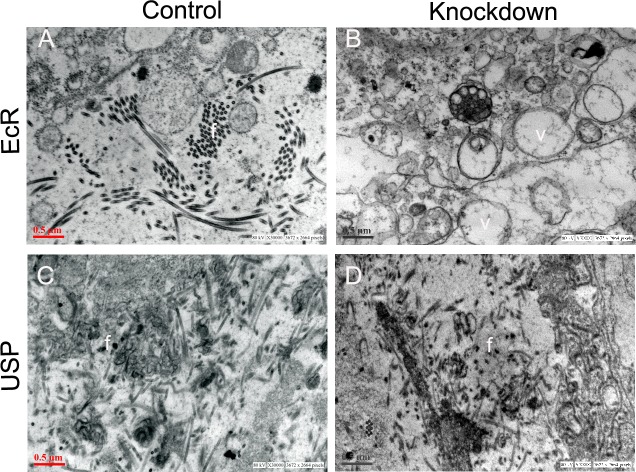
The effect of knockdown of EcR or USP on the structure of male accessory glands.To assess the effect of depletion of EcR or USP, accessory glands were analyzed either at the ultrastructural level (panels at the top). Depicted at the top are the electron micrographs of male accessory glands from (A) EcR control (B) EcR knockdown (C) USP control and (D) knockdown males. Accessory glands from EcR control, USP control and USP knockdown males show normal protein filamentous structures (labeled as f) throughout in their lumen. However, glands of EcR knockdown have extreme vacuolization (v) and lack filamentous structures in the lumen. A minimum of five tissues from each group was used for ultrastructural analysis.